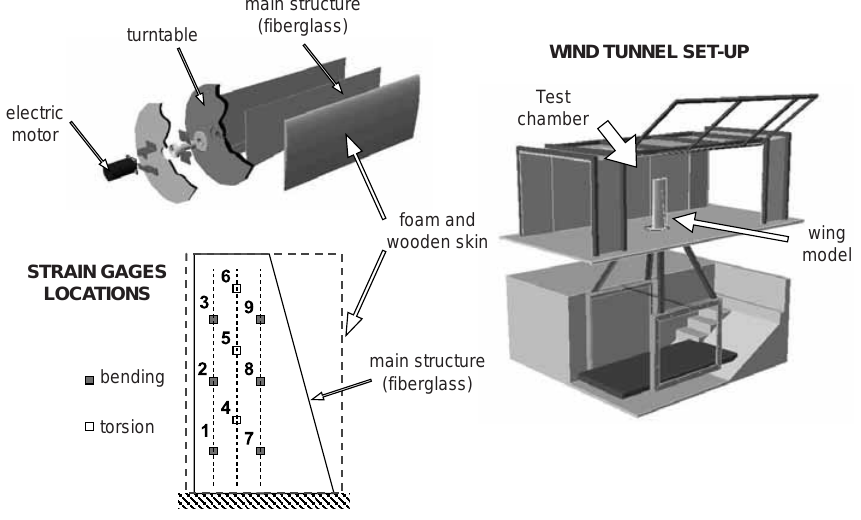
Fig. 1. Experimental set-up and strain gages